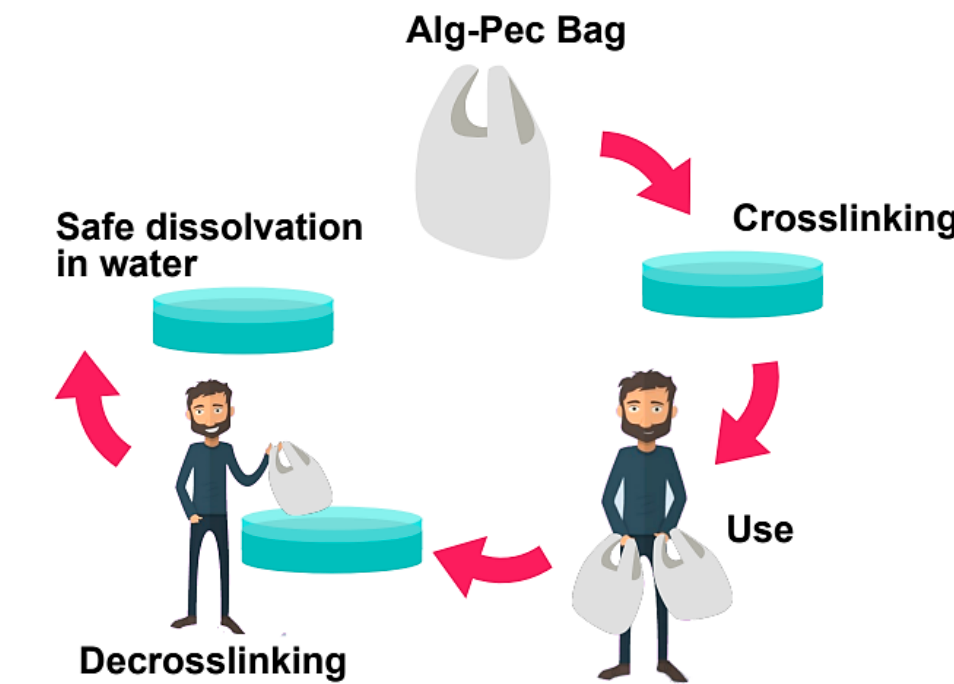
Figure 3. Potential utilization and disposal of Alg–Pec based films.